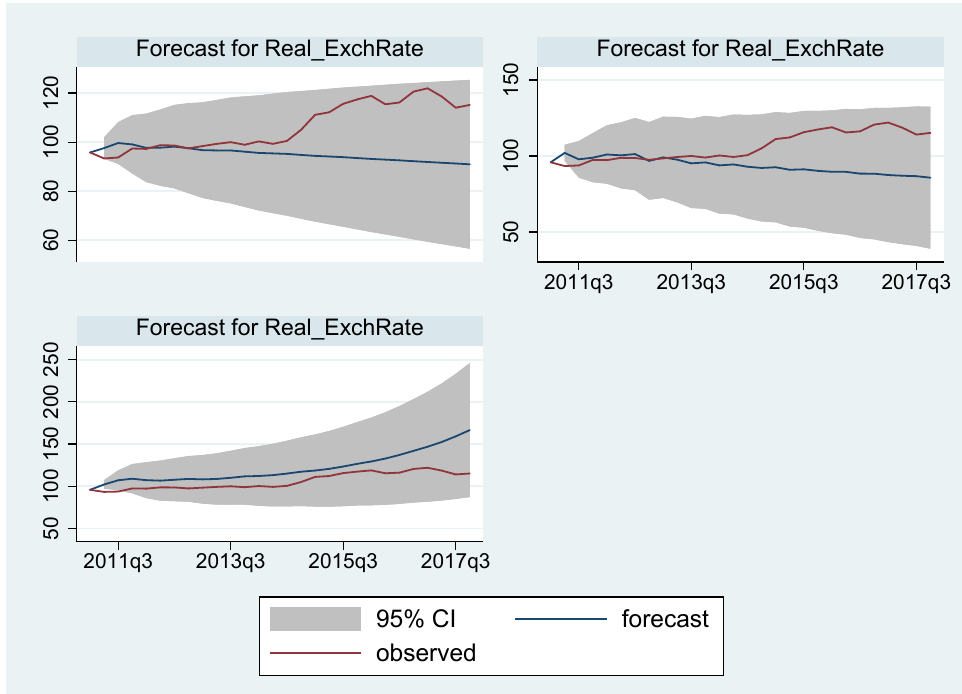
Figure 2. US—VEC-Model